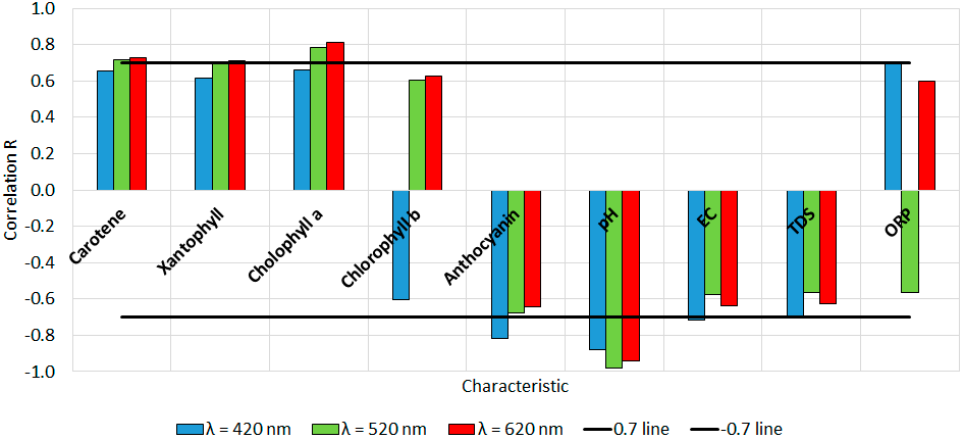
Figure 4. Correlation between NDAI spectral index and physicochemical characteristics of mulberry leaves.